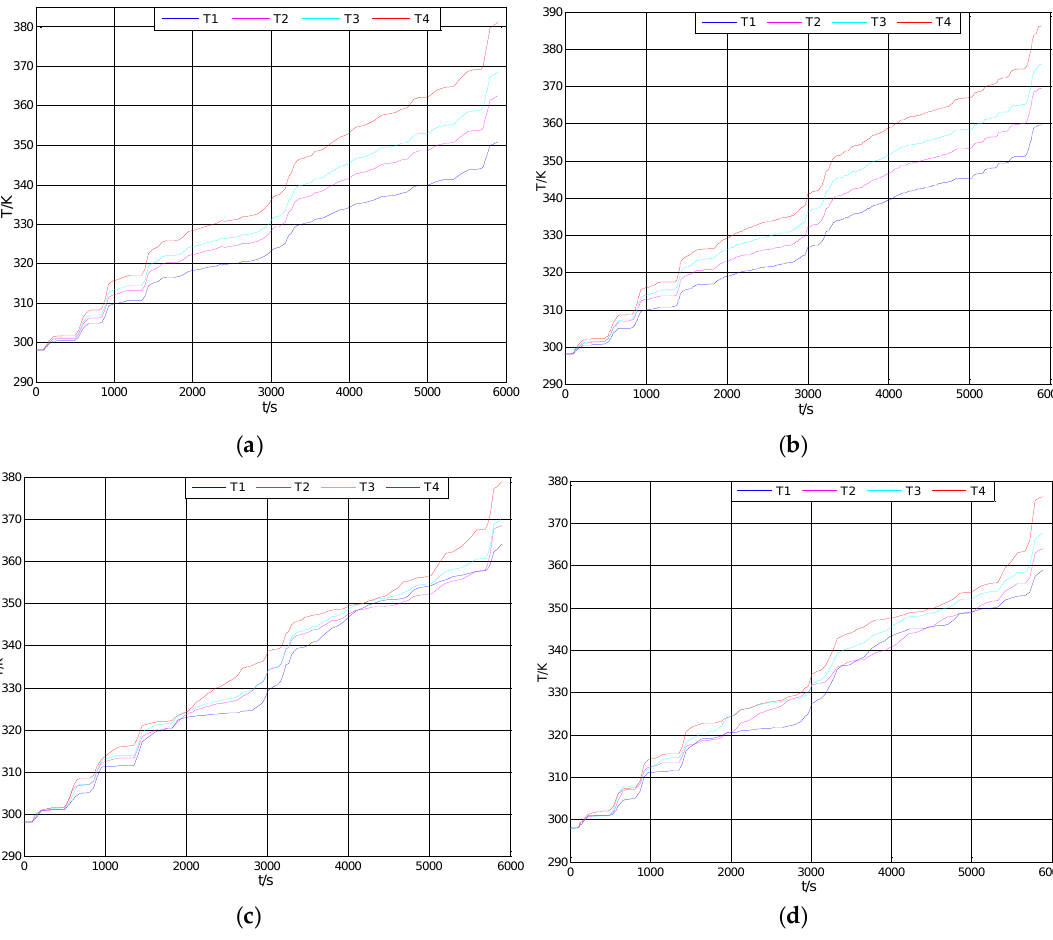
Figure 6. The results of the temperature under different balancing control conditions. ( a ) Non-balancing control; ( b ) SOC balancing control; ( c ) Multi-objective balancing control; ( d ) MOPBC.